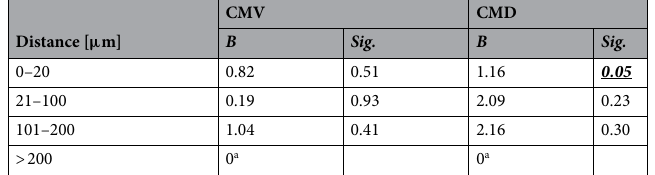
Table 2. The Influence of the vertical distance between MG-63 cells and the titanium surface on cell movement velocity (CMV) and cell movement direction (CMD) (n = 15). Significant values are in [bolditalics and underline]. Statistical significance was set at P < 0.05. a This coefficient is set to zero because it is redundant.